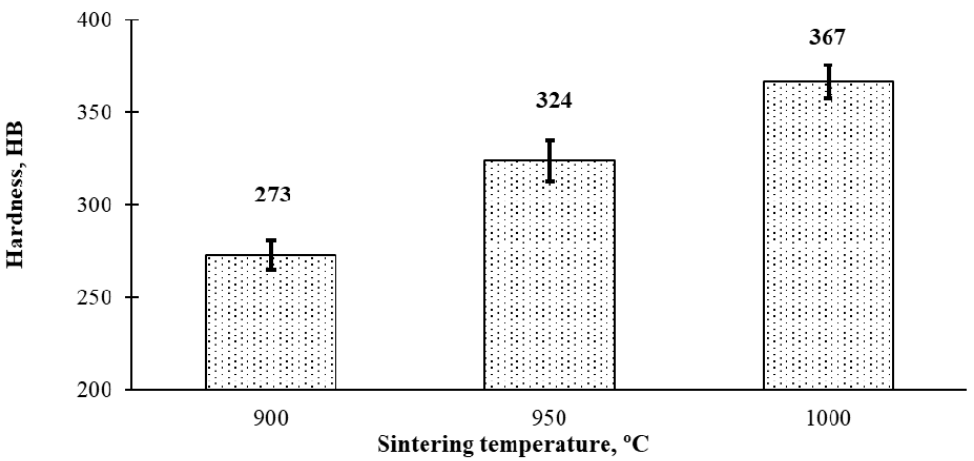
Figure 5. Brinell hardness of spark plasma sintered M3/2–50% Fe materials.